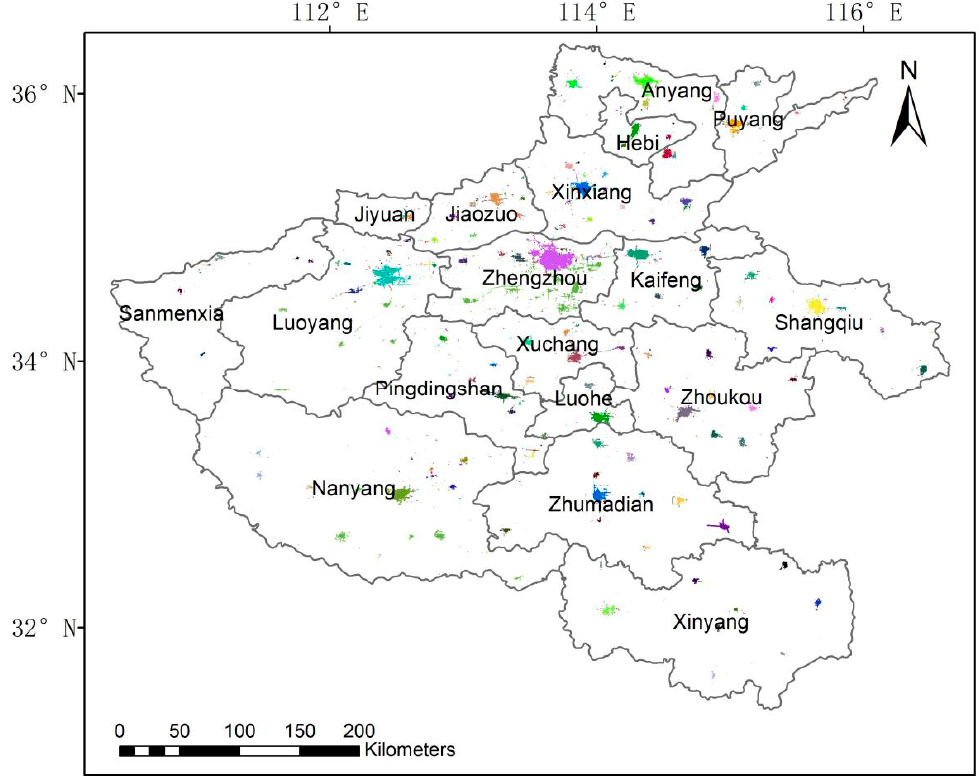
Figure 7. The distribution of connected components at level 1. Remote Sens. 2020 , 12 , x FOR PEER REVIEW 10 of 19